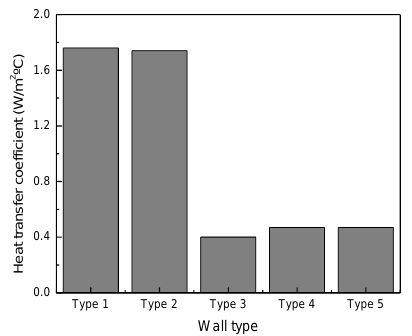
Figure 7. Energy performance assessment: heat transfer coefficient. Compared with the Portuguese Standard in which the maximum U value is established (Portaria n.º 138-I/2021 [69]) for each of the winter climate zones (Table 4), it is possible to state that wall types 1 and 2 can be considered as walls with low energy performance, not complying with the maximum values established by the Portuguese thermal standards. Only wall type 3 complied with I1 and I2, while wall types 4 and 5 complied with I1. None of these walls fit the legal requirements for the most severe winter climate zone in main- land Portugal. Table 4. Thermal coefficients for the opaque envelope of new or retrofitted buildings — mainland Portugal: U máx (W·m − ²·K −1 ) (source: [69]). Winter Climate Zones I1 I2 I3 U máx 0.50 0.40